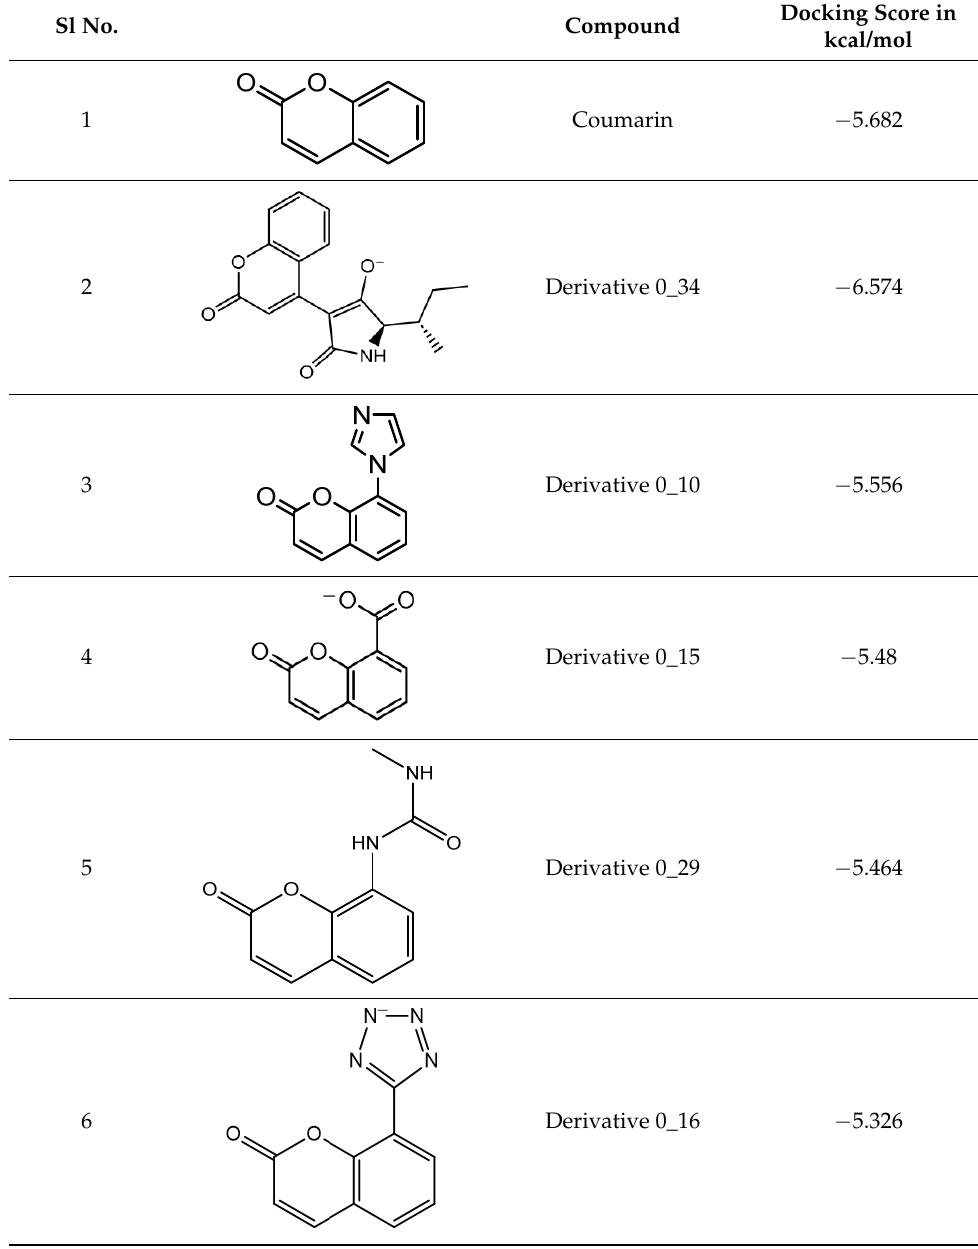
Table 1. List of enumerated coumarin derivatives along with their docking scores in kcal/mol. Sl No. 1